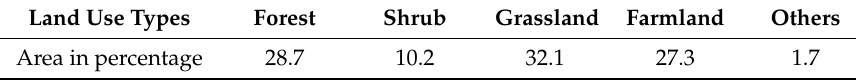
Table 1. The land use types in percentage terms in the Jinghe River basin (Unit: